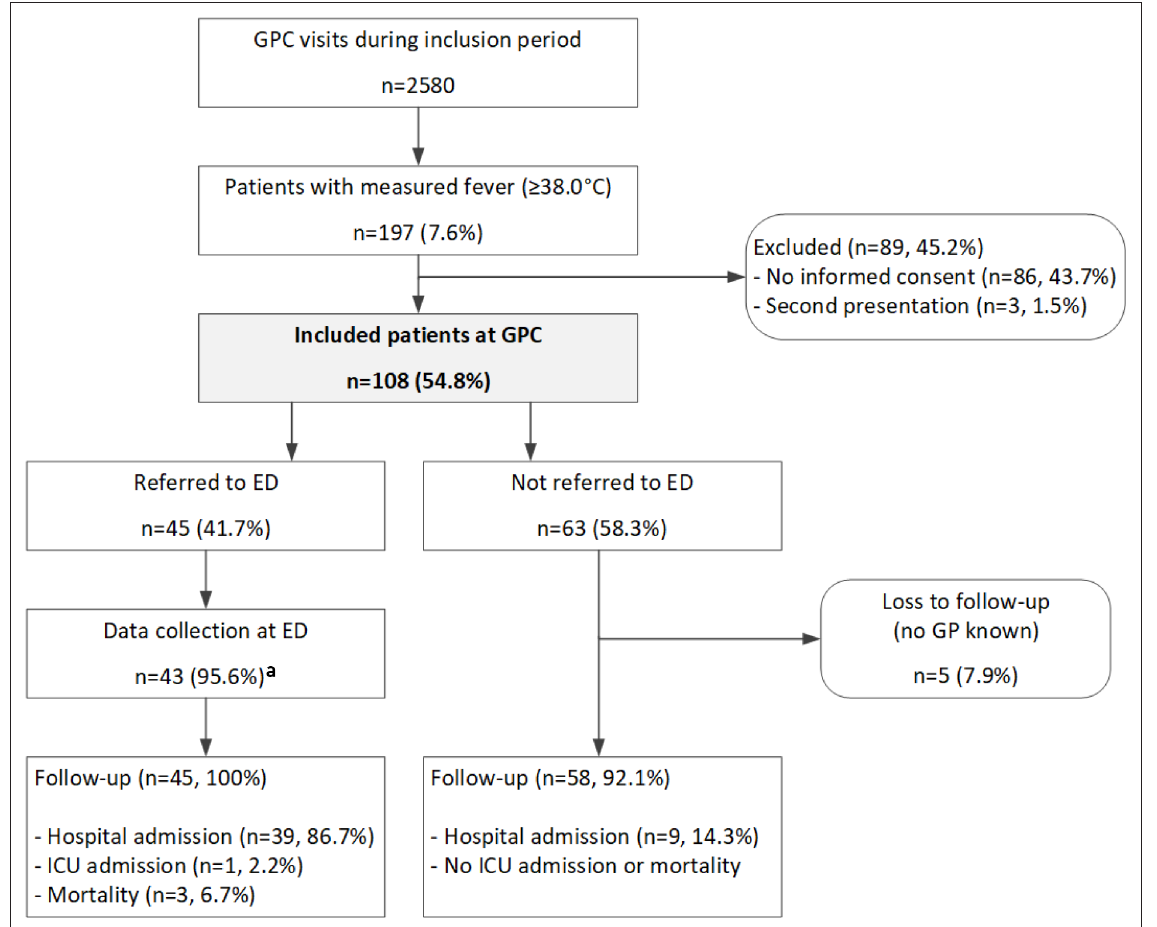
Figure 1 Flowchart of study population. a Two patients were treated in a non- participating ED. GPC = GP cooperative. ED = emergency department. ICU = intensive care